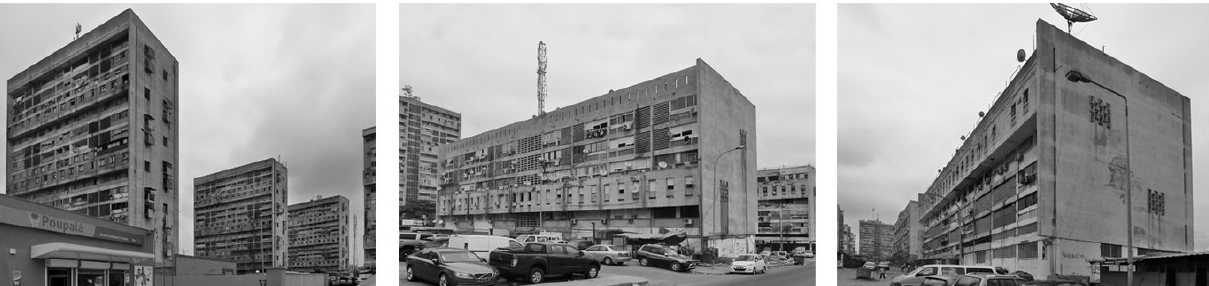
Figure 4. Simões de Carvalho, Alfredo Pereira, and José P. da Cunha. Prenda neighbourhood: Housing types A, B, and D. Photos taken by the author in